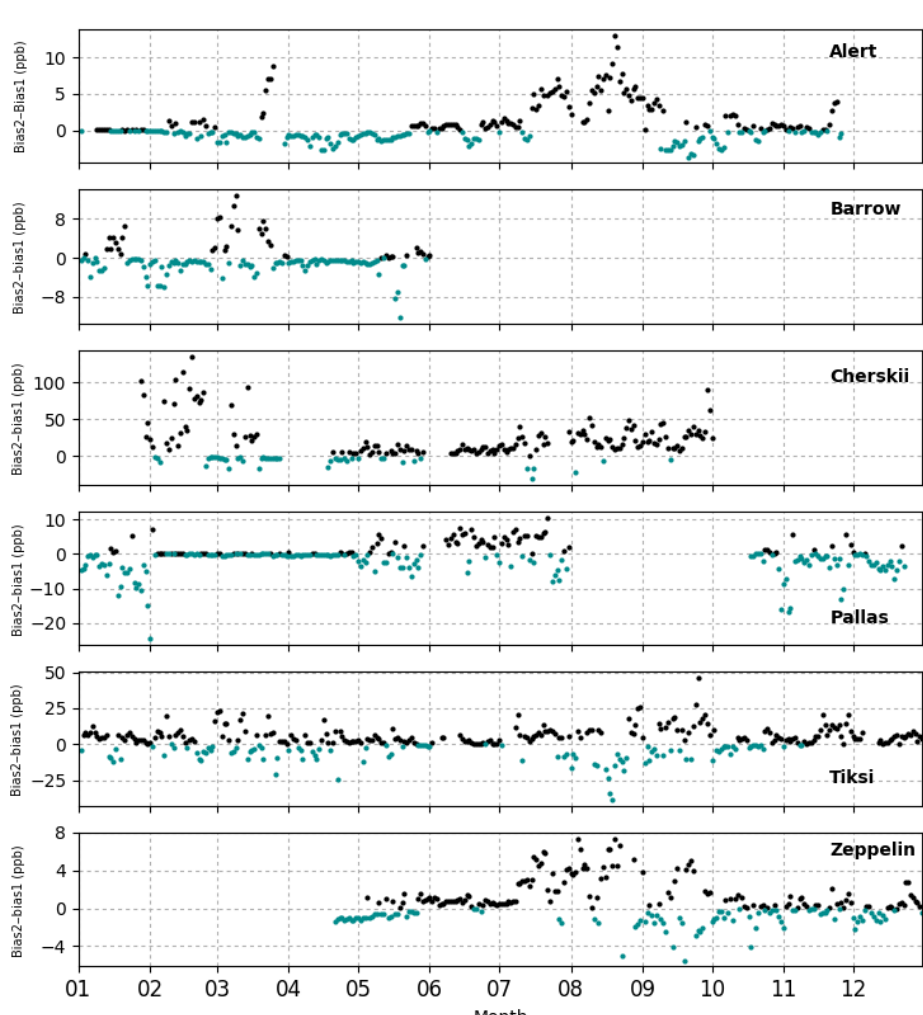
Figure 9. Difference between the absolute values of the biases between simulated and observed CH 4 for simulations using the two freshwater inventories at six measurement sites in 2012. Simulation 1 is the reference simulation. Simulation 2 includes the bLake4Me-derived lake emission inventory. Blue points indicate negative values. Note that different scales are used for each